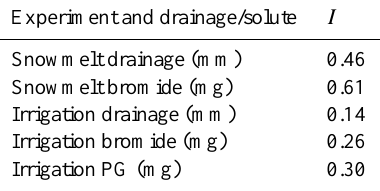
Fig. 13. Comparison of total leaching per cell: drainage of the snowmelt and irrigation experiment (a) , bromide leaching of the snowmelt and irrigation experiment (b) , and bromide leaching and PG leaching of the irrigation experiment (c) . The drainage was scaled with the drainage of the entire sampler of either the snowmelt or irrigation experiment. Solute leaching is given in % from what would have leached in each cell with perfect uniform flow. Table 2. Spatial autocorrelation according to Moran’s I . A value of 1 indicates perfect spatial autocorrelation, and − 0.01 no spatial